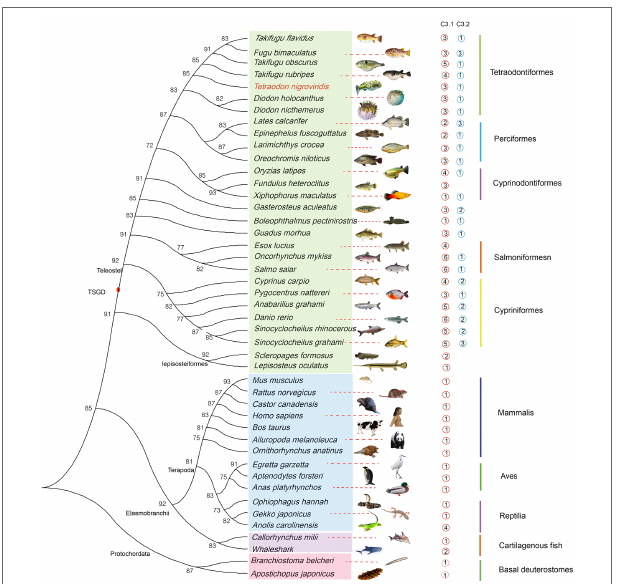
FIGURE 6 | Dendrogram showing the number of predicted C3 genes in various fishes and other vertebrates. TSGD, teleost specific genome duplication.